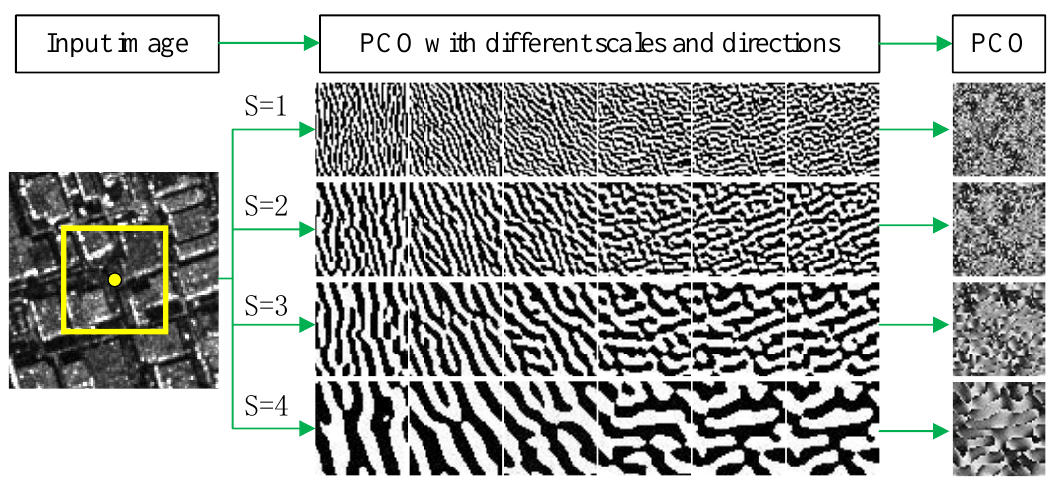
Figure 4. Multi-scale PCOs.